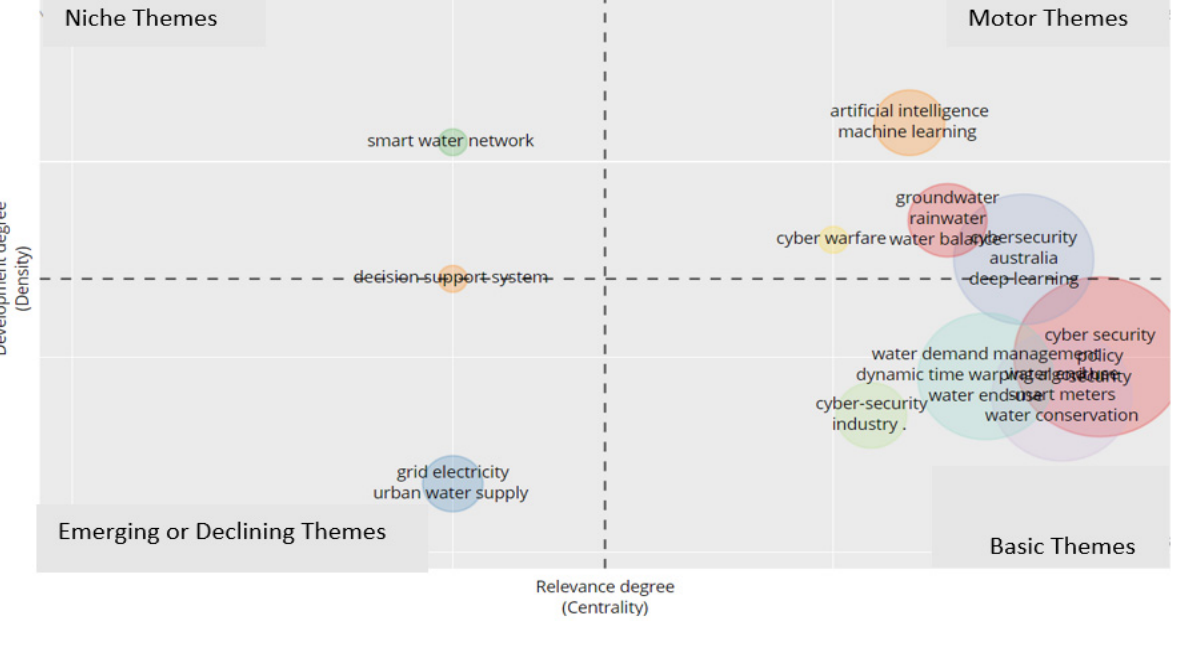
Figure 7. A thematic map of Australia’s cybersecurity challenges relating to critical water